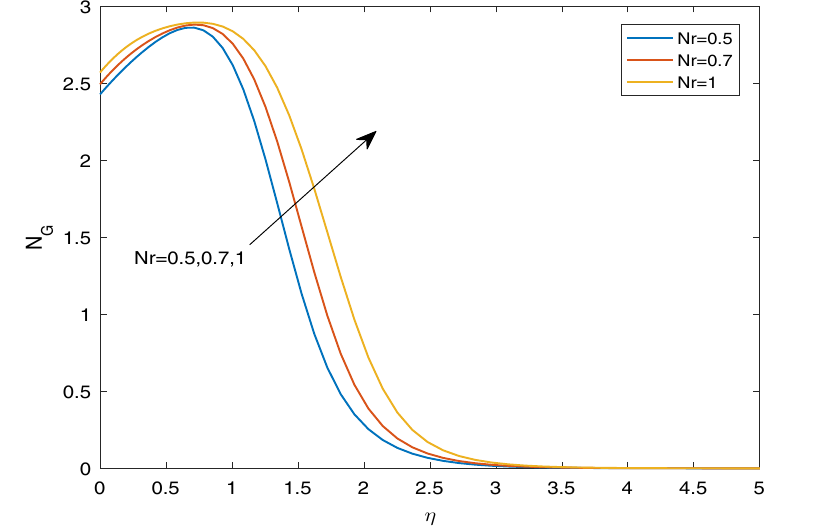
Figure 25. Sketch of N G against Nr .